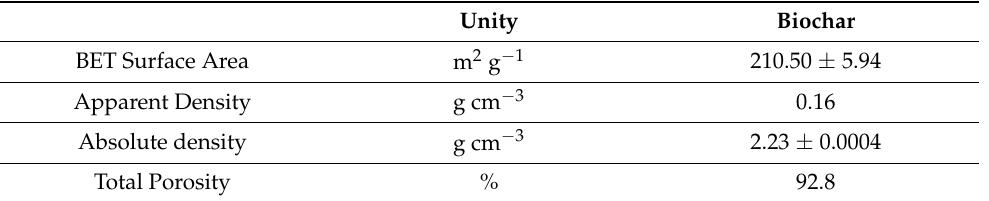
Table 3. BET, bulk density and total porosity results on biochar. Unity Biochar